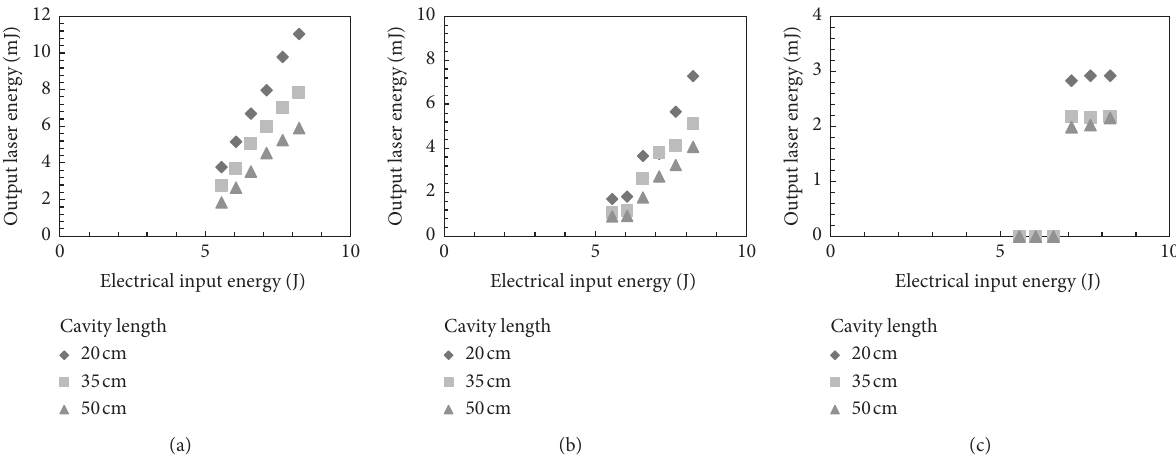
Figure 5: Output laser energy (SESAM R � 86%): (a) Cr 4+ :YAG T � 90%; (b) Cr 4+ :YAG T � 80%; (c) Cr 4+ :YAG T � 70%. 00.010.020.030.040.05